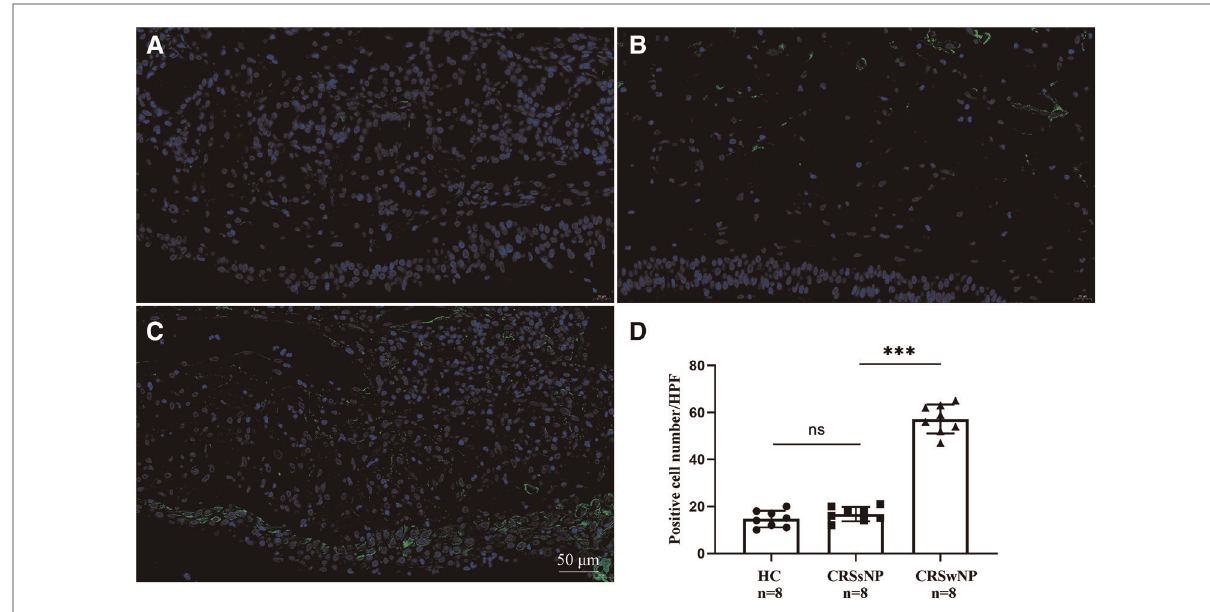
FIGURE 6 Immuno fl uorescence and S100A4 protein expression in the tissue indifferent groups. Representative immuno fl uorescence images of HC ( A ), CRSsNP ( B ) and CRSwNP group ( C ). ( D ) Quanti fi cation of S100A4 + cells in immuno fl uorescence staining among three groups. (magni fi cation, x 400) *** p < 0.001, ns, no signi fi cance. Abbreviations: CRSwNP, chronic rhinosinusitis with nasal polyps; HC, healthy control; CRSsNP, chronic rhinosinusitis without nasal polyps.